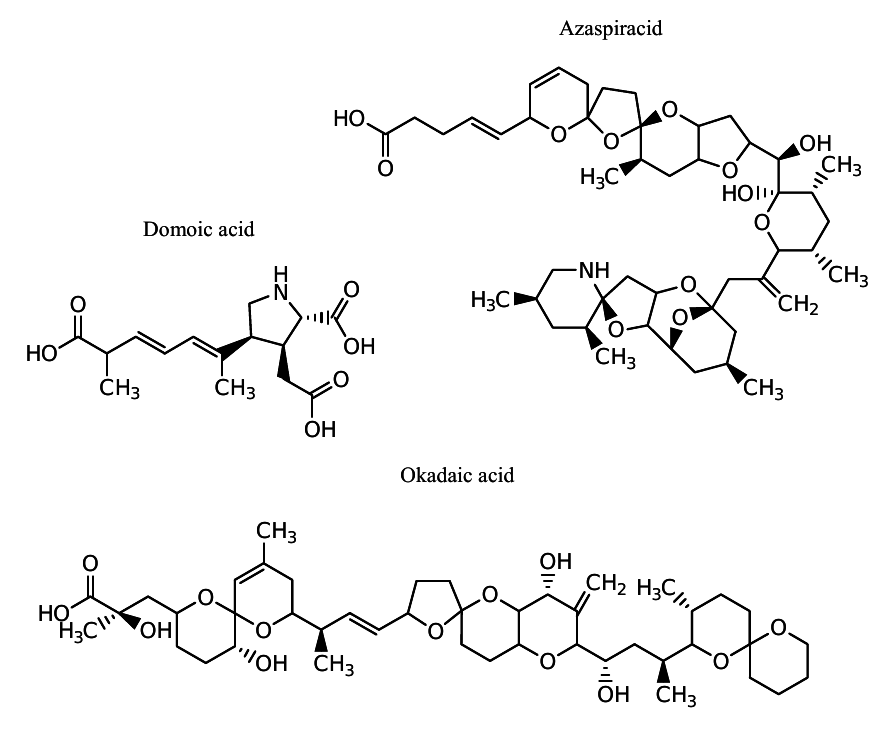
Figure 8. Structures of commonly encountered